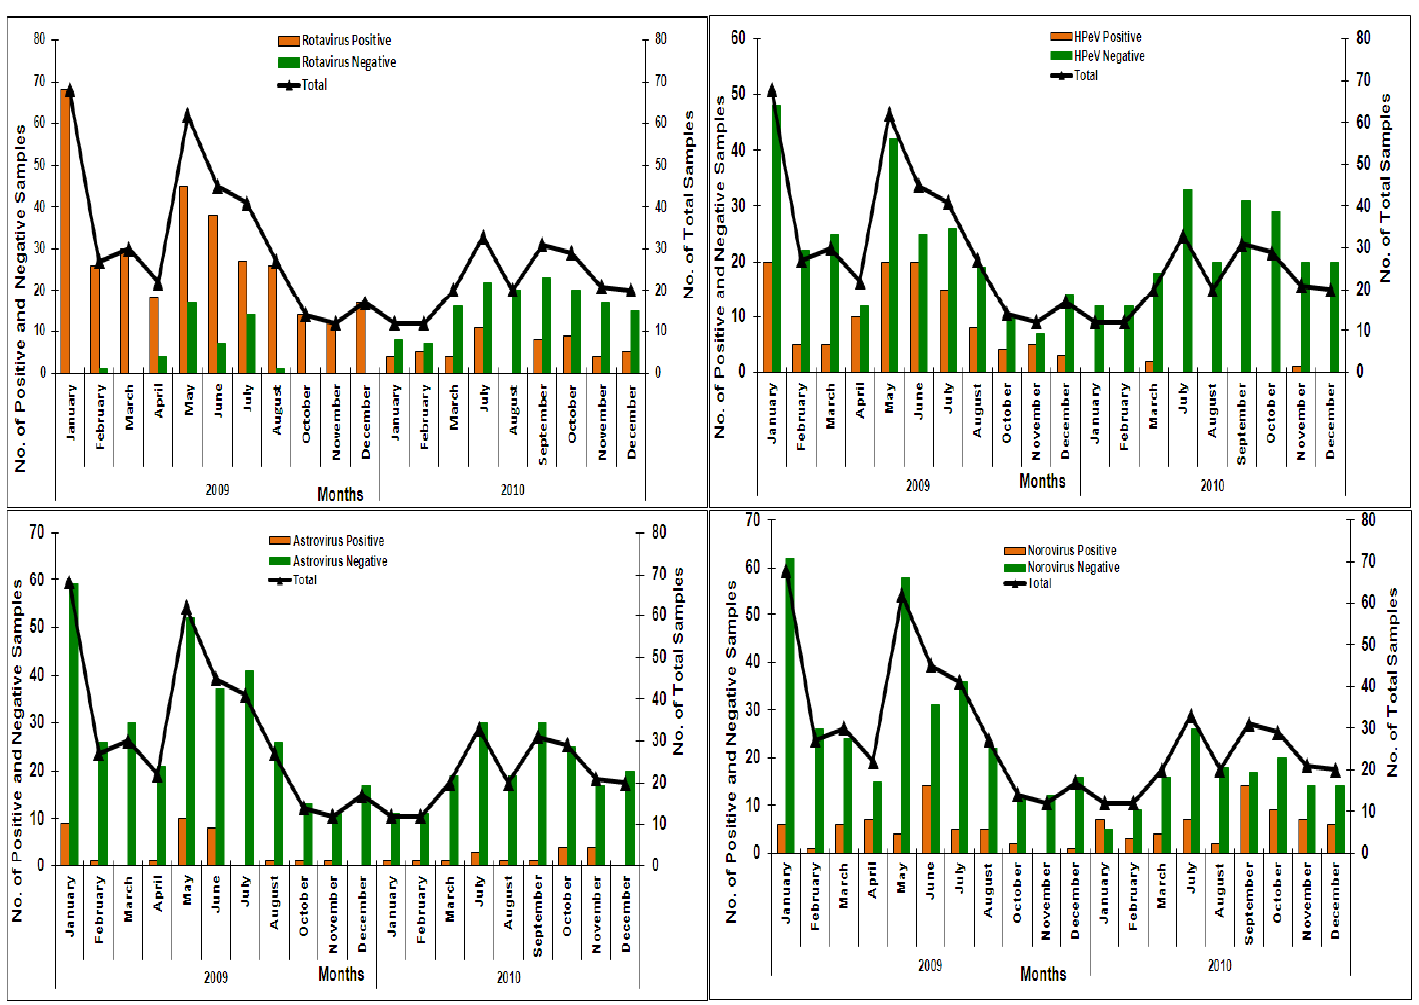
Figure 2. Month-wise distribution of positive, negative, and total cases tested for rotavirus, parechovirus, norovirus, and astrovirus. The months per each year (2009 and 2010) are shown on the X-axis. Number of positive and negative cases are represented on the primary Y-axis and the number of total cases is given on the secondary